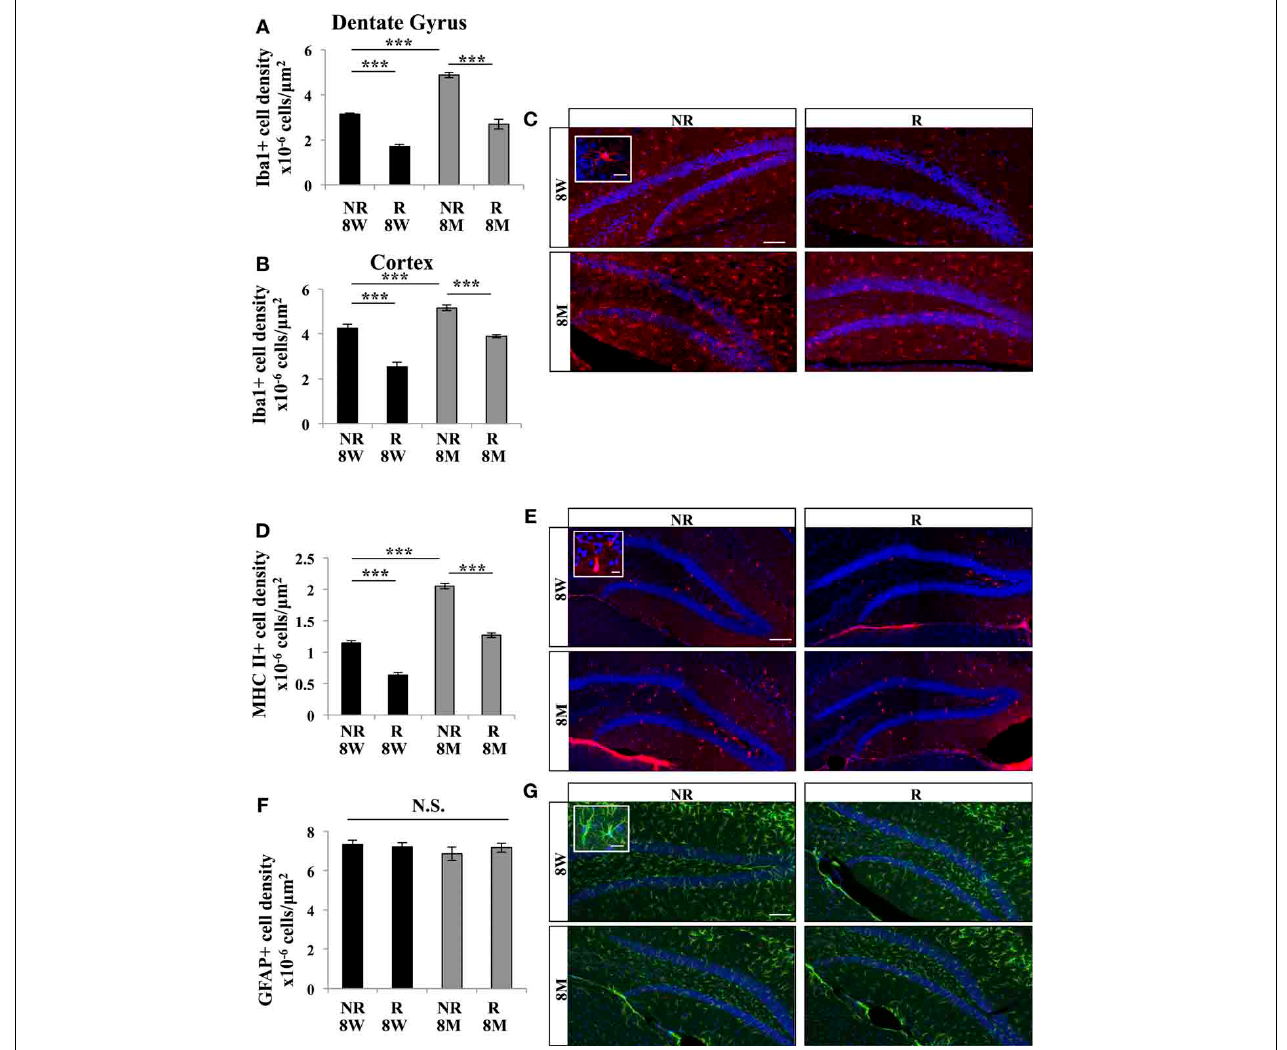
FIGURE 2 | Effect of running and aging on the density of microglia. (A) Histogram showing the density (cells/ μ m 2 ) of Iba1-expressing cells in the dentate gyrus (including hilus, granule cell layer and molecular layer). (B) Histogram of the density of Iba1-expressing cells in the cortex. (C) Confocal maximal projection micrographs of hippocampal sections immunostained for Iba1. Inset: Higher magnification confocal micrograph of an Iba1-immunolabeled cell. (D) Histogram of the density of MHC II-expressing cells in the dentate gyrus. (E) Confocal maximal projection micrographs of hippocampal sections